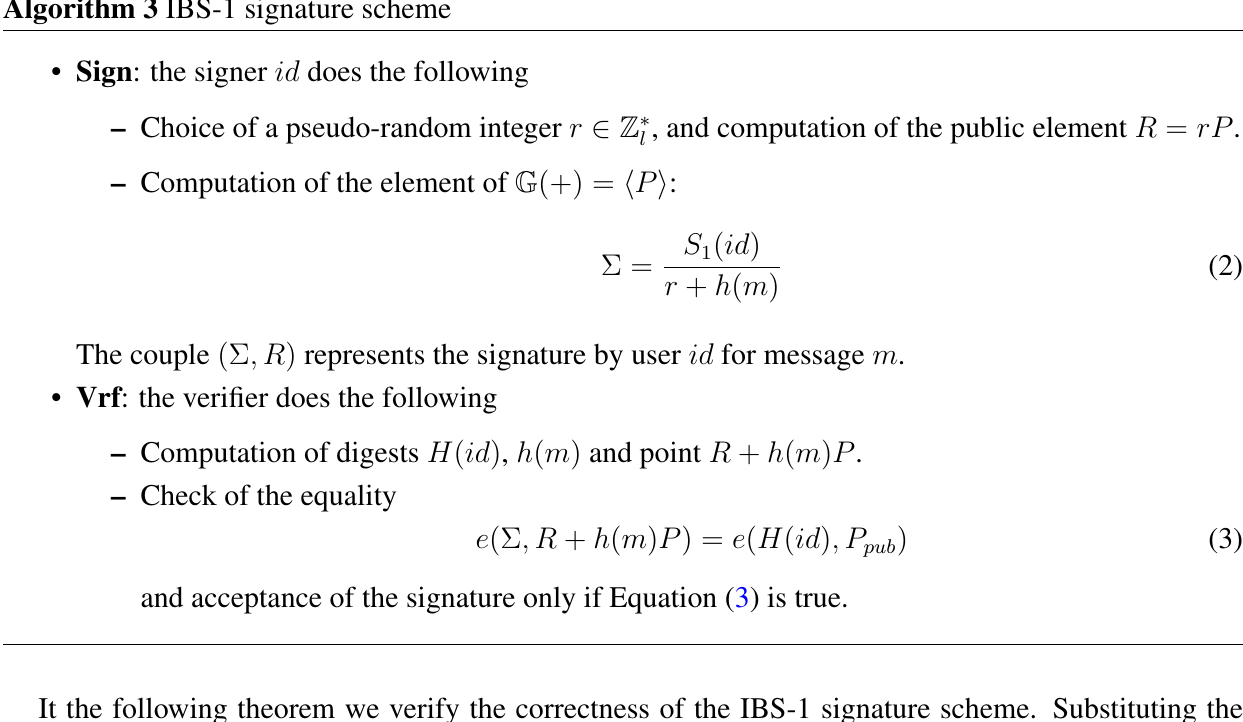
Algorithm 3 IBS-1 signature